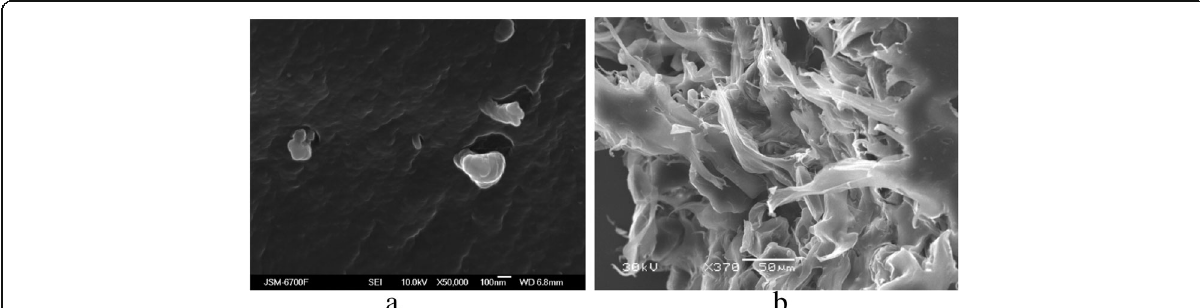
Fig. 4 SEM images of cross section of composite cation-exchange membrane. Small aggregates of ZHP nanoparticles are seen ( a ), no particles are seen in large pores ( b )